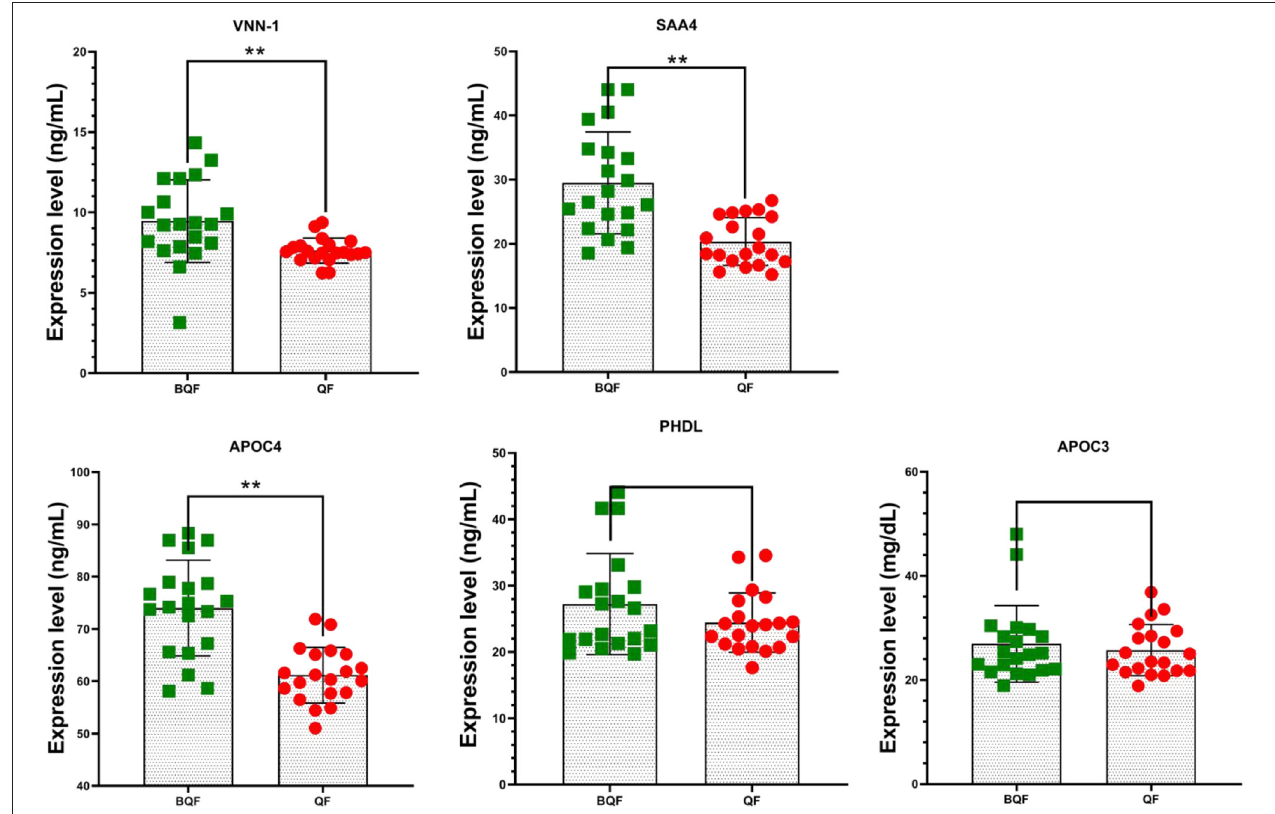
FIGURE 8 | Five plasma protein levels in subclinical VE deficiency cows (QF) and healthy controls (BQF) were selected for verification using enzyme-linked immunosorbent assay in subclinical VE deficiency cows ( n = 20) and healthy controls ( n = 20). Plasma levels of VNN-1, SAA4, and APOC4 were significantly lower in subclinical VE deficiency cows than those of the control group (* p < 0.05, ** p < 0.01), while no significant differences were detected in the expression of APOC3 and PHDL ( p > 0.05).